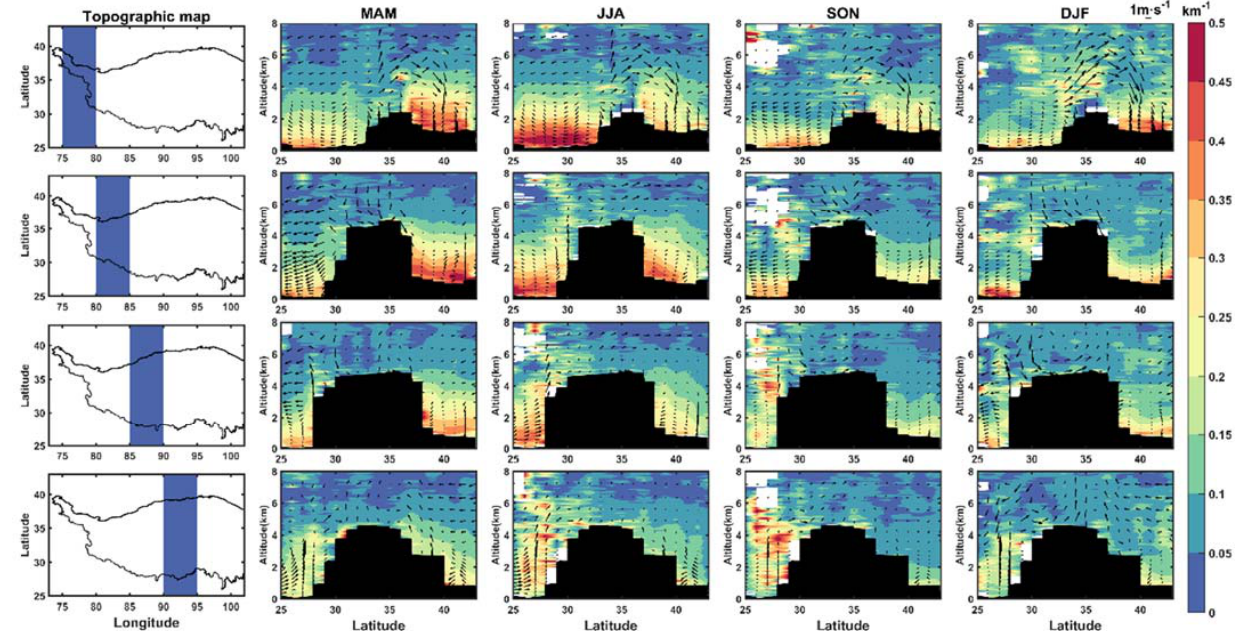
Figure 5. Distributions of the seasonal dust extinction coefficient ( σ D at 532 nm and the wind field on four longitudinal transects (75° − 80°, 80° − 85°, 85° − 90°, and 90° − 95° E) during 2007–2020. The black shaded area and the white blank area indicate the elevation and the missing data, respectively; the same applies below.